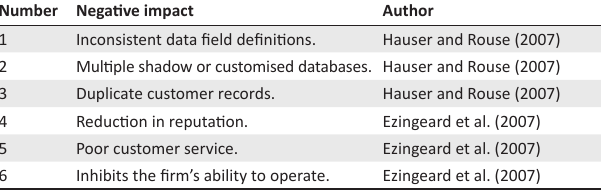
TABLE 2: Negative operational and tactical impact of poor information